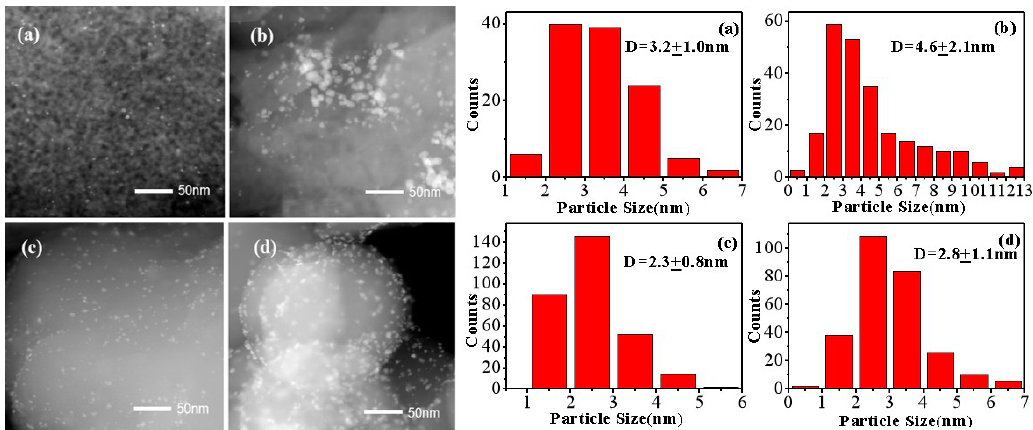
Figure 2. HAADF-STEM images and corresponding size distribution of Pt 0.5 /SiO 2 before ( a ) and after reaction ( b ), as well as Pt 0.5 /SiO 2 -Shiff before ( c ) and after reaction ( d ).